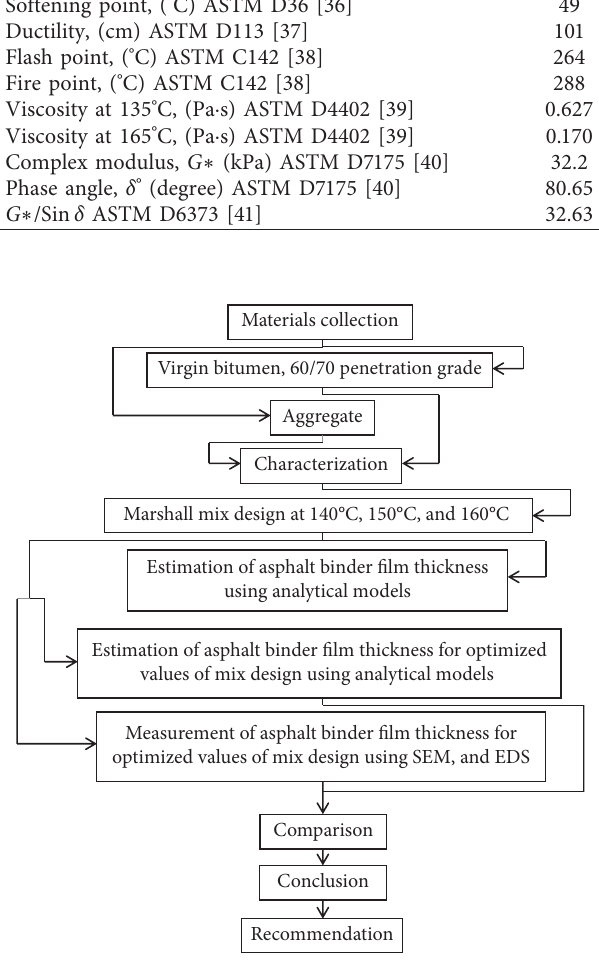
Figure 1: Flow chart showing research methodology.